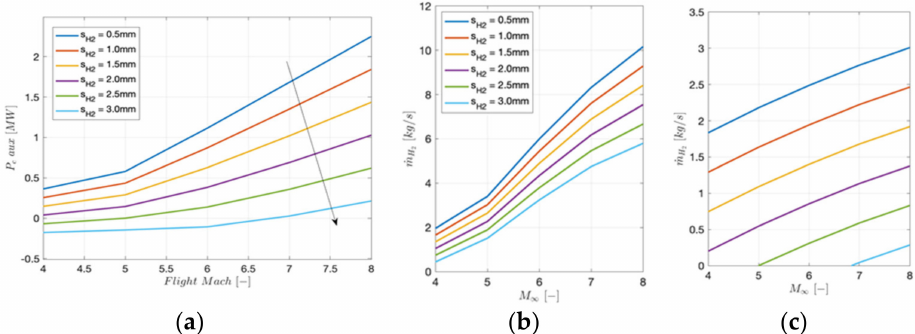
Figure 28. ( a ) Auxiliary compressor power (required power) as function of the Mach number for different values of thickness of the boil-off hydrogen insulation layer; ( b ) variation of the boil-off hydrogen mass flow of the primary heat exchanger with the Mach number for different thicknesses of the insulation layer; ( c ) variation of the boil-off mass hydrogen mass flow of the secondary heat exchanger with the Mach number for different thicknesses of the insulation layer (see legend in Figure